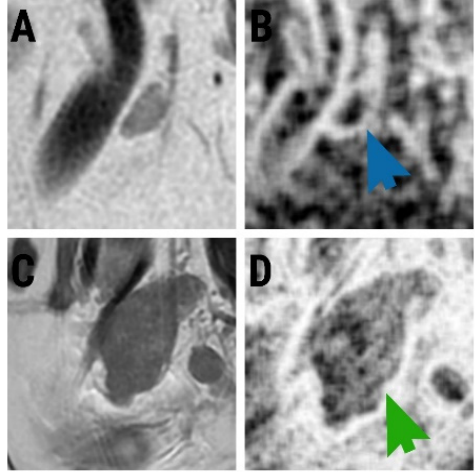
Figure 3. ( A ) A sagittal T2-weighted image of a non-tumoral lymph node in a 58-year-old patient; ( B ) generated map of this image based on CZ1S6Entropy parameter (blue arrow pointing to the lesion). ( C ) A sagittal T2-weighted image of a 61-year-old patient with pathologically confirmed metastatic lymph node; ( D ) generated map of this image based on CZ1S6Entropy parameter (green arrow pointing to the lesion).